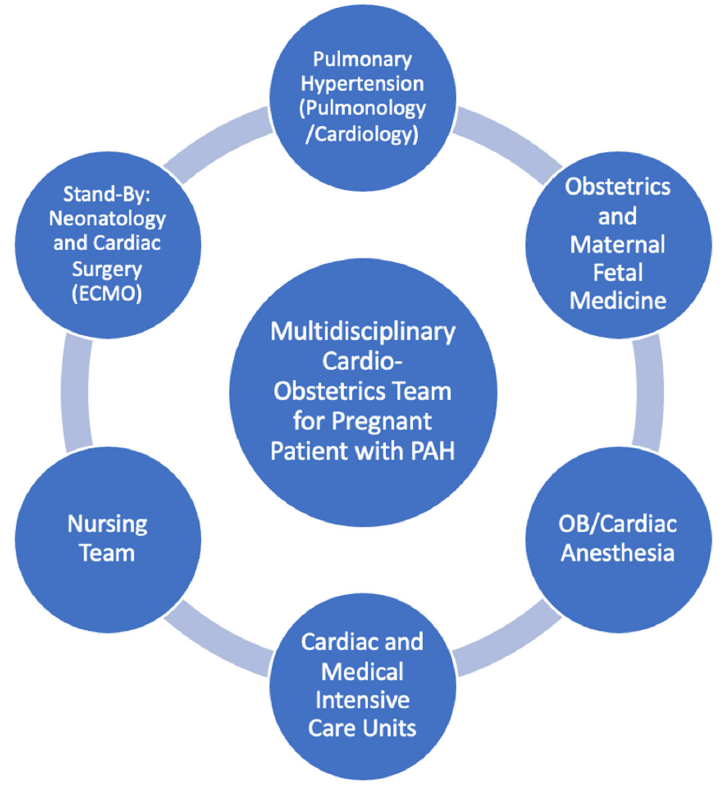
Figure 3. Multidisciplinary cardio-obstetrics care team for pregnant patient with PAH. ECMO = extracorporeal membrane oxygenation. OB = obstetrics.